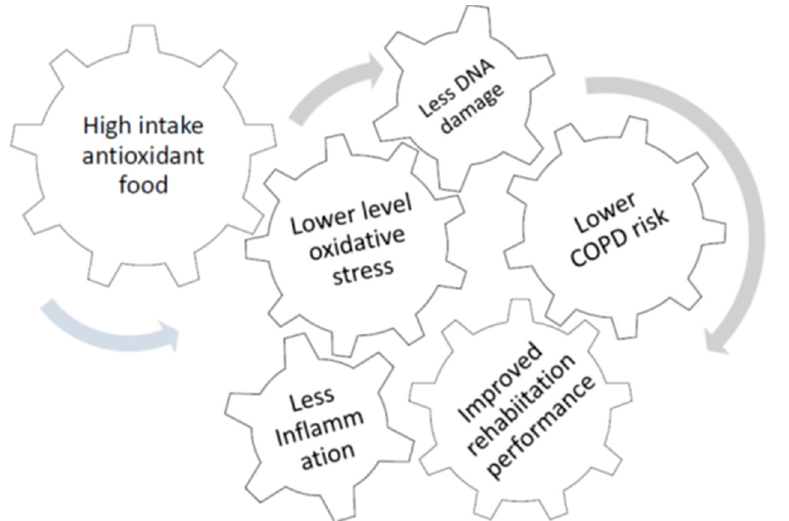
Figure 1. Complex machinery illustrating how a high consumption of food with antioxidant properties may be beneficial in reducing the level of oxidative stress and inflammation, but also improving genomic stability, reducing the risk of COPD, and improving physical performance.